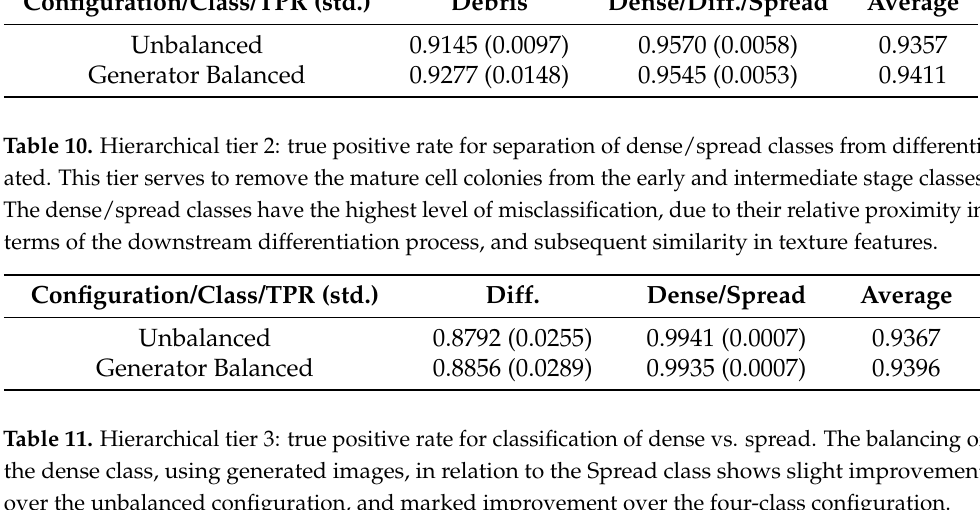
Table 9. Hierarchical tier 1: true positive rate for temporal combination of viable cell classes vs. debris cells. This stage acts as a filtration step to remove unviable and unhealthy colony areas. Configuration/Class/TPR (std.)